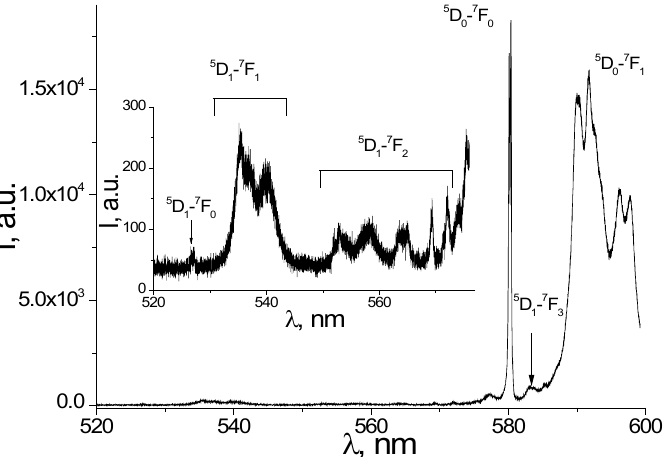
Figure 7. High-resolution emission spectrum for the 520–600 nm region at 300 K, λ exc = 405 nm. If the structural difference between two Eu 3+ sites is small, the energy difference between the different peaks in the 5 D 0 → 7 F 0 transition is also small [19,40]. As discussed in [40], in the case of two distinct isomers in the crystal structure, this usually can result in quite a large energy difference between the transitions in the 5 D 0 - 7 F 0 region. The splitting character of the 5 D 0 → 7 F 0 transition suggests a dinuclear molecule and not distinct isomers since the splitting is as small as 0.96 meV (~6 cm − 1 ). Such a small energy separation of two components of the 5 D 0 → 7 F 0 transition may indicate that both Eu 3+ ions are located in similar environments, defined by the coordination sphere of six oxygen and two nitrogen atoms (Figure 1) [38].